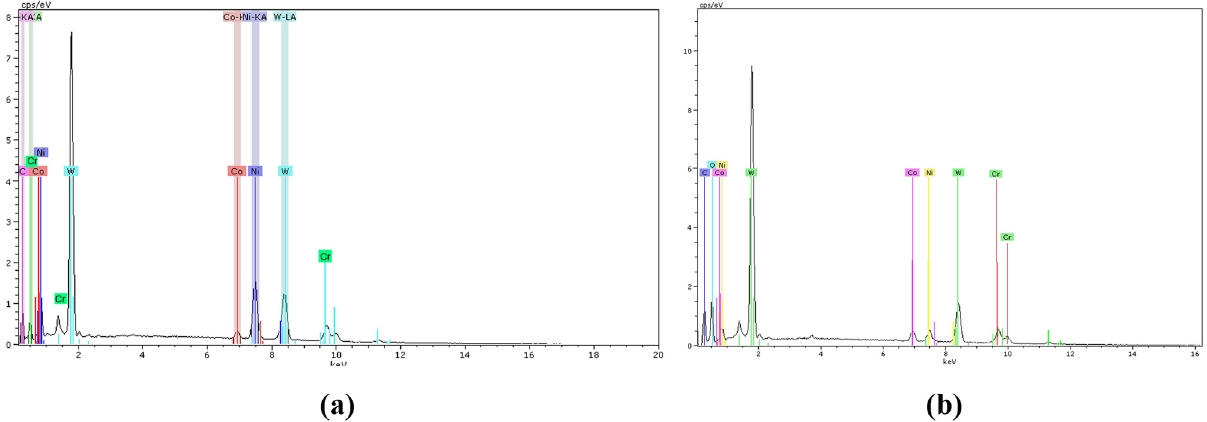
Figure 5: EDX spectrum of ( a ) C3 and ( b ) C6 composites at 1,000°C.